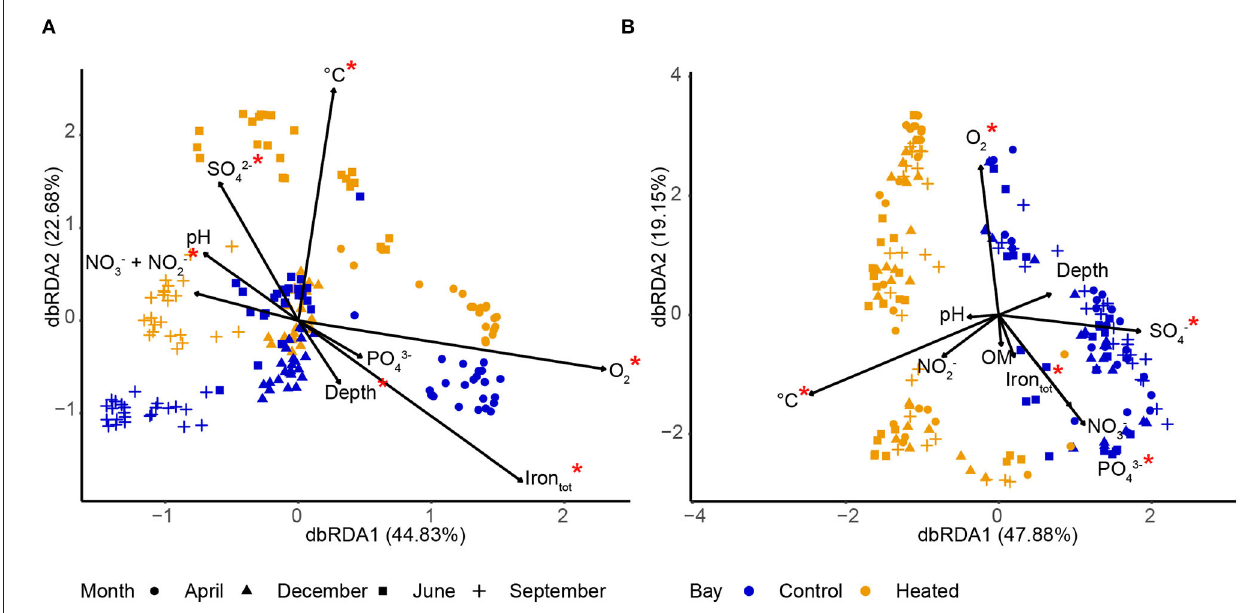
FIGURE 5 | Distance-based redundancy analysis (db-RDA) of communities and environmental variables in bottom water (A) and sediment (B) in the heated (orange) and control (blue) bays. Constrained ordination using samples from 0 to 1cm sediment of three replicates for each site ( n = 8) on each sampling month ( n = 4) in each bay ( n = 2), giving a total of 192 samples. The input ASV data were based on relative abundances (%). Significantly different ( p < 0.05) bottom water (A) and sediment pore water (B) environmental variables are marked with a red asterisk (statistics detailed in Supplementary Table 3 ), and the degree of variation explained by the first and second axes is